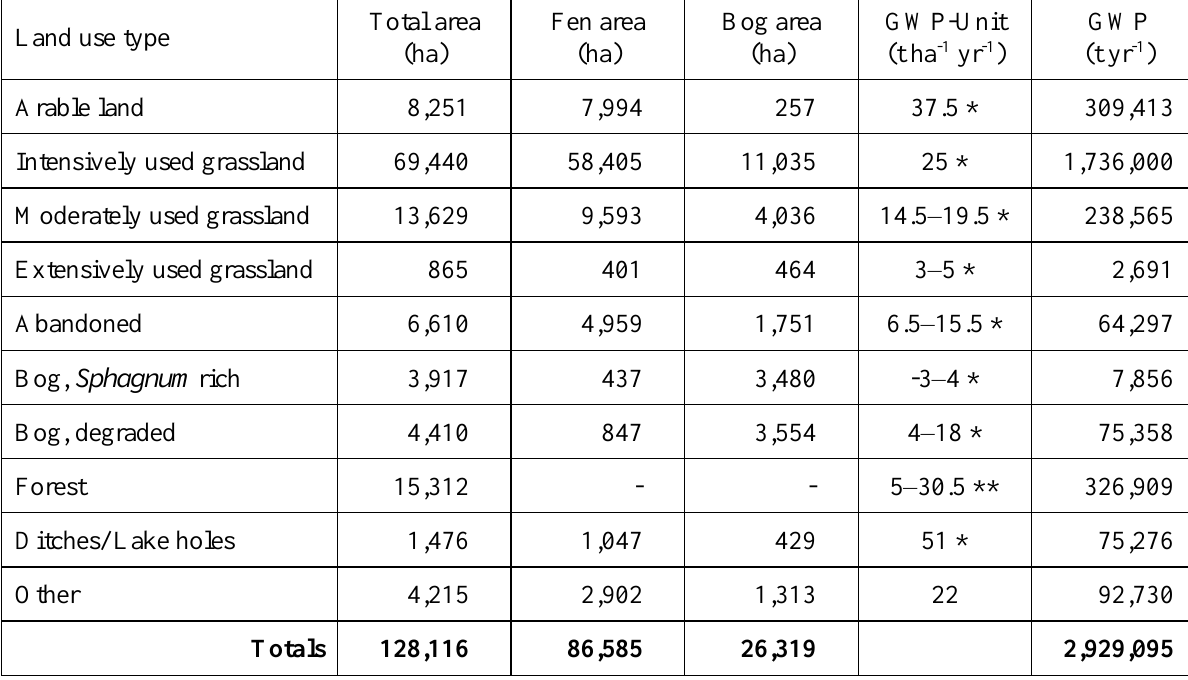
Table 2. Summary of the distribution of vegetation/management types on peatlands in Schleswig-Holstein. The dispersion on fen peat and bog peat is shown, along with the CO * GWP corresponding to Hirschelmann et al. (2020); ** GWP corresponding to Schrautzer et al.